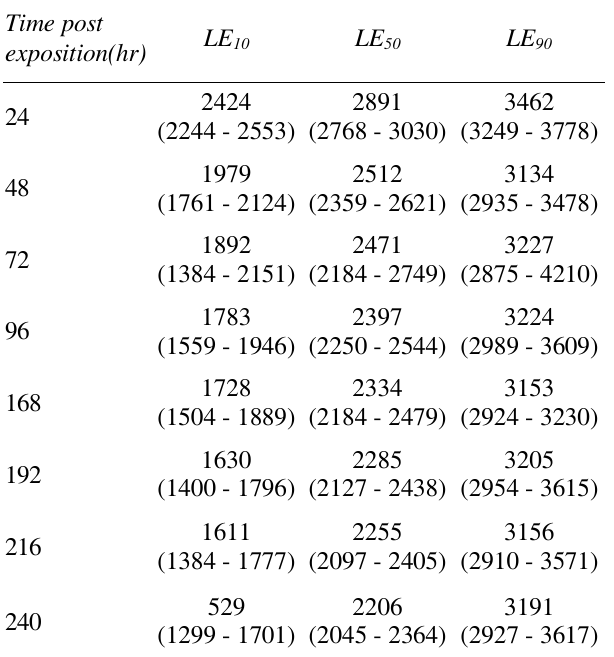
Table 1 : Lethal Exposition Toxicity and Intervals of Confidence of UV-B in Bufo arenarum embryos (Joule/m 2 ) Time post